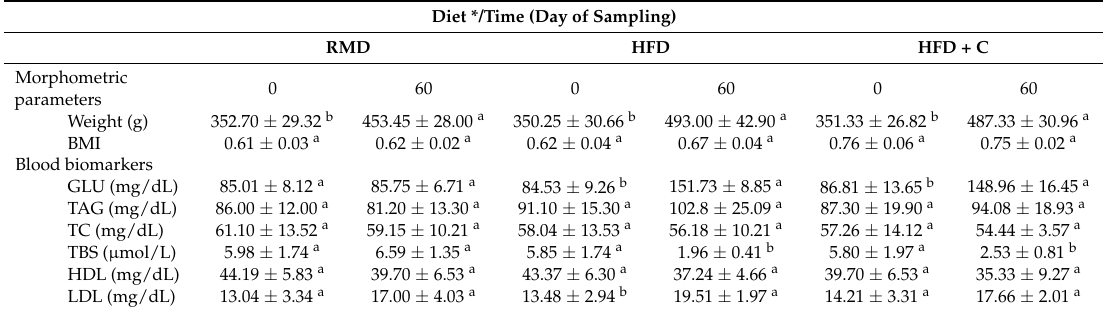
* Diet: RMD = Rodent Maintenance Diet; HFD = High Fat Diet; HFD + C = High Fat Diet + Citrolive™; Morphometric parameters: BMI = body mass index Blood biomarkers: GLU = glucose; HDL = high density lipoprotein cholesterol; LDL = low density lipoprotein cholesterol; AST = aspartate transaminase; ALT = alanine transaminase; TAG = triacylglycerol; TC = total cholesterol; TBS = total bile salts; a,b Values not shearing the same superscript within the same diet and parameter or biomarker are significantly different for p <